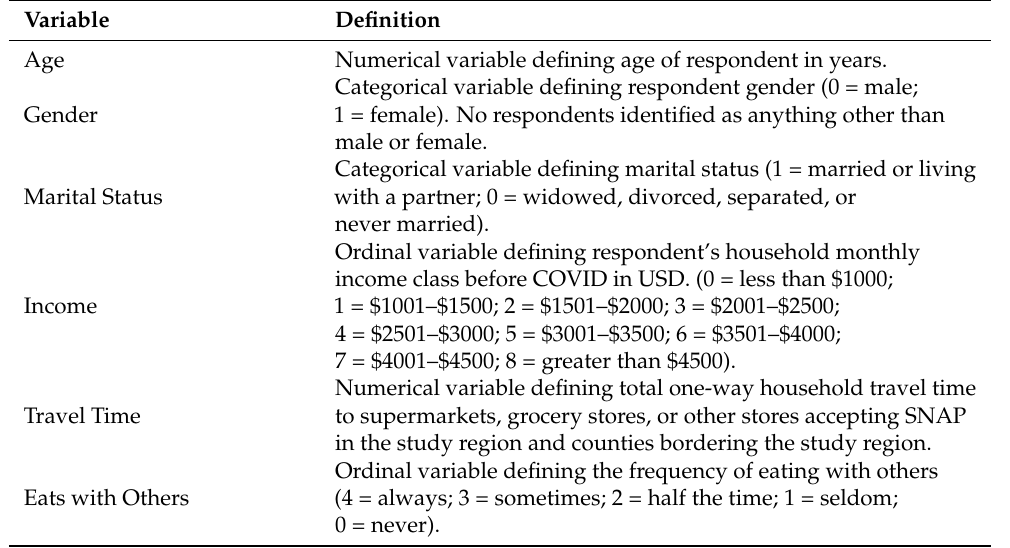
Table 2. Path analytical model variables and